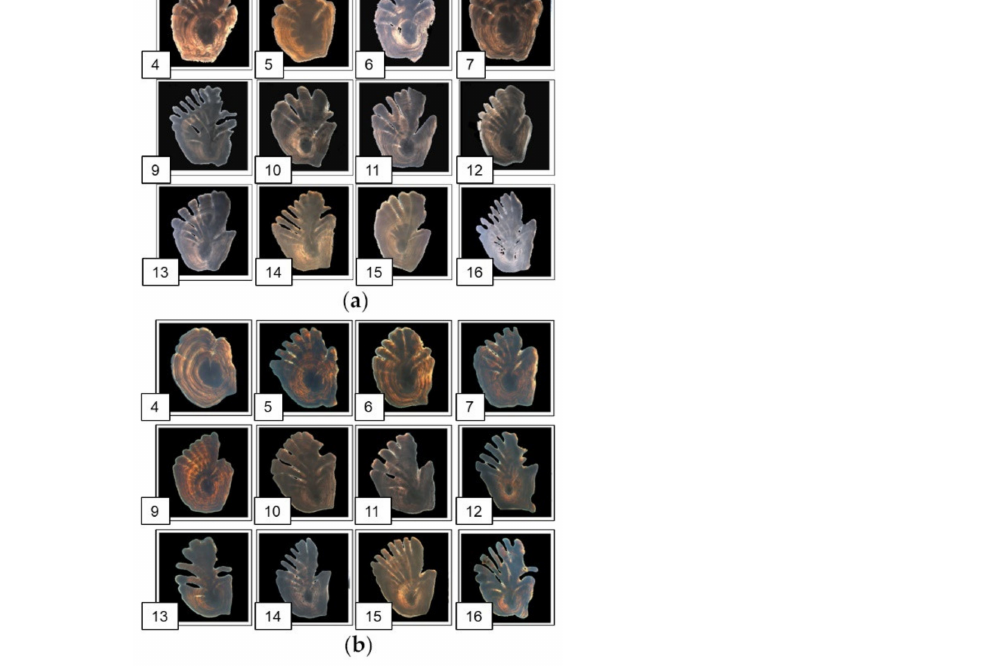
Figure 4. Examples of otolith images where the standardization preprocessing step was applied. ( a ) Standardized version of images from Figure 1a acquired and annotated by the Norwegian lab; ( b ) Standardized version of images from Figure 1b acquired and annotated by the Icelandic lab. Table 1. Summary of the different experiments with their associated